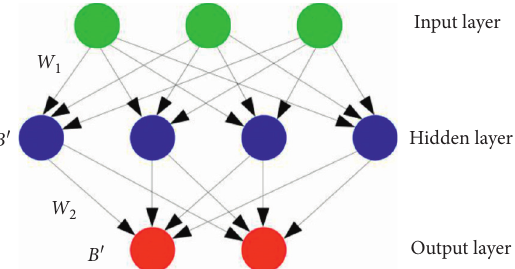
Figure 7: The topological structure diagram of the BP neural